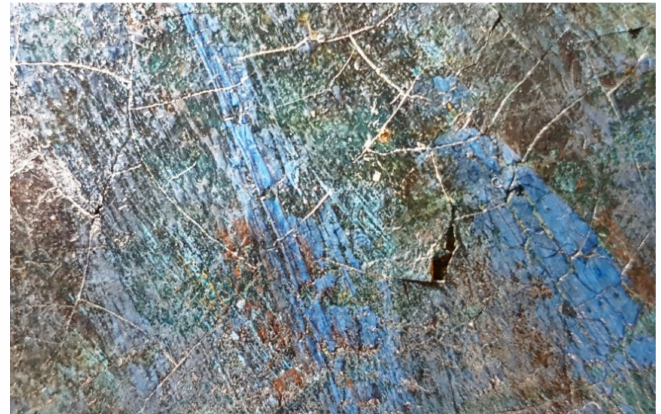
Figure 3. Detail of a lifted and cracked area in VIS-RAD